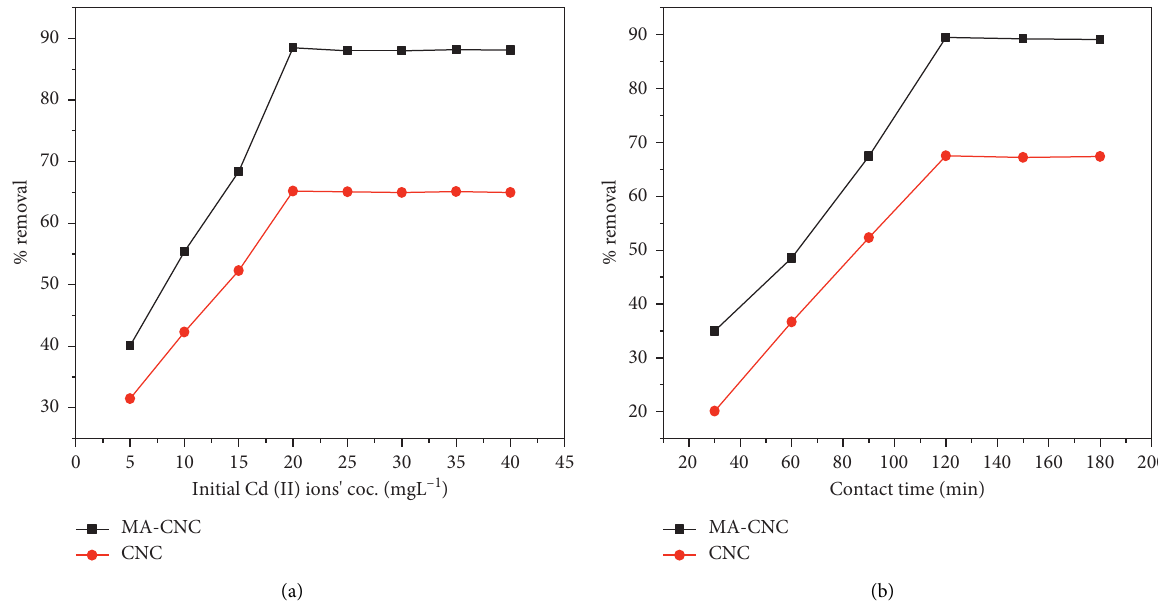
Figure 5: The effect of initial concentration (a) and contact time (b) for the removal of Cd(II) ions from wastewater, respectively, at an optimum temperature of 20 ° C, adsorbent dosage of 0.5, solution pH of 8, and agitation speed of 250